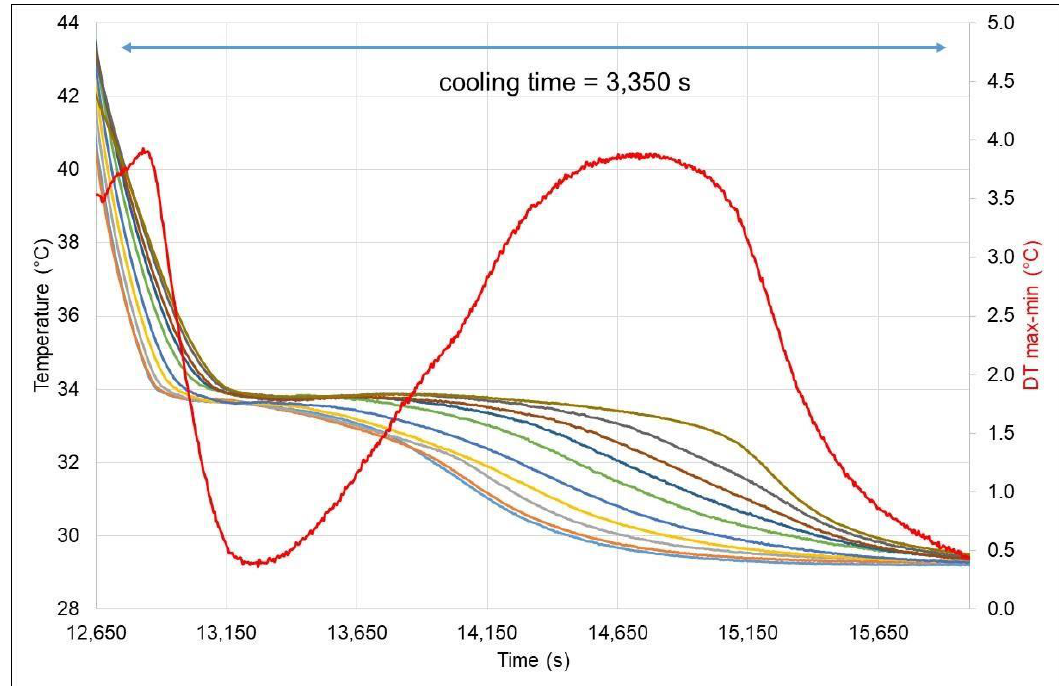
Figure 19. Measured surface temperature of the cells when the cooling airflow was characterized by a speed of 2 m/s. The heating elements were off over the period indicated in the chart.